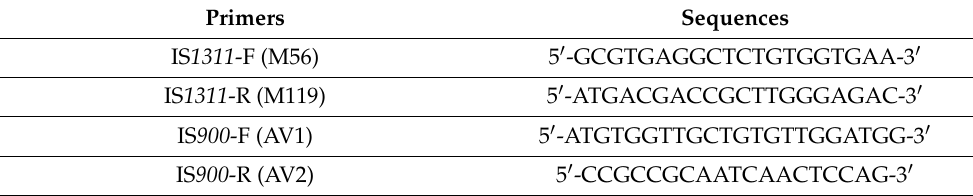
Table 3. Sequences of primer sets used for PCR IS 1311 and qPCR IS 900 analyses of this